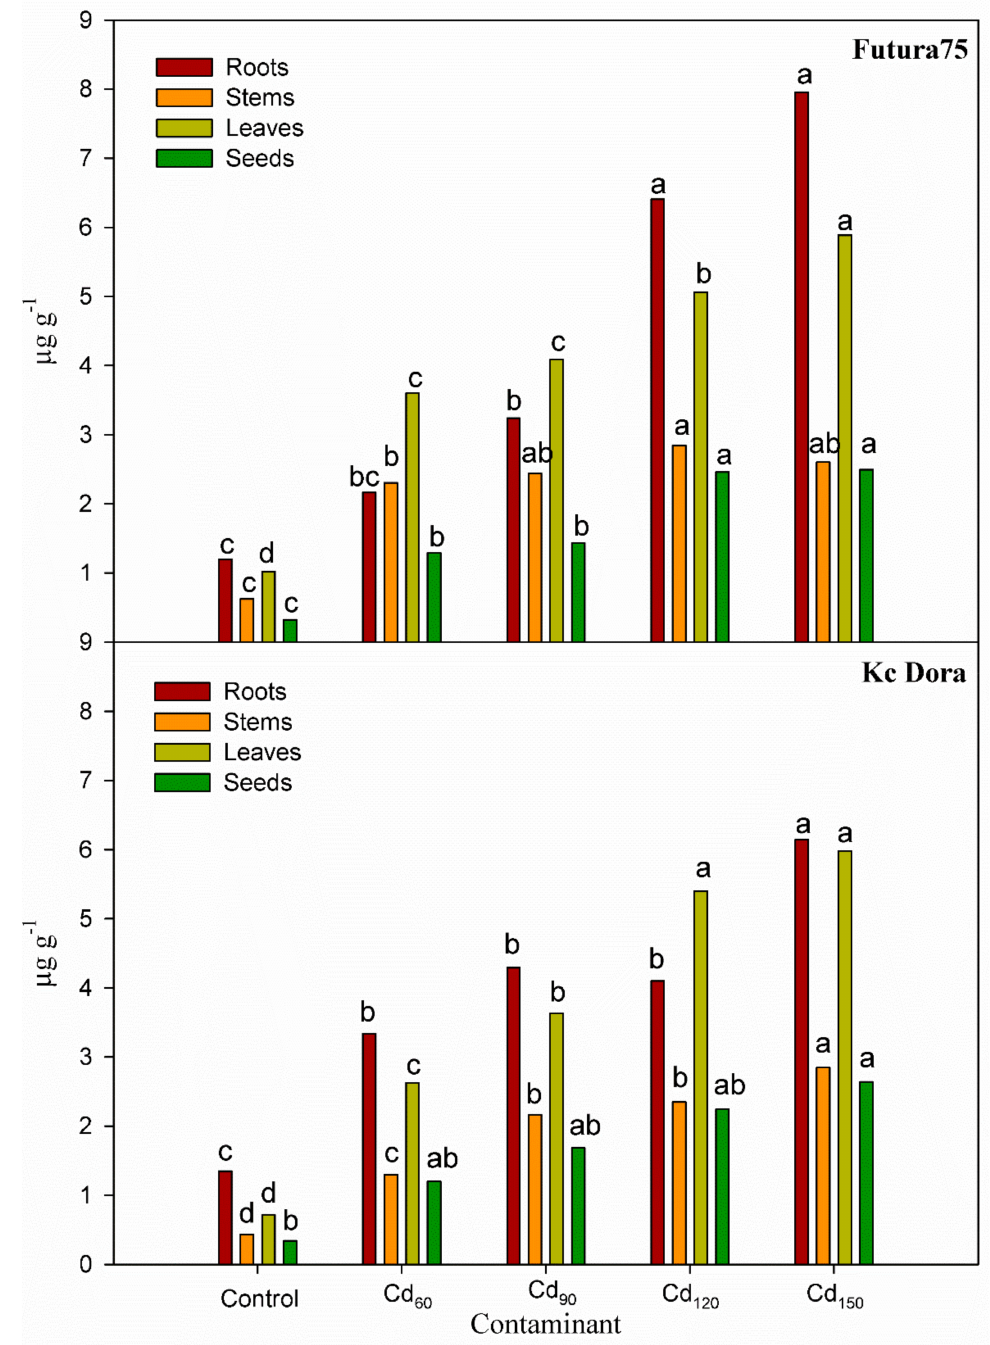
Figure 2. Concentration of cadmium ( µ g g − 1 ) in roots, stems, leaves, and seeds in Futura 75 and KC Dora. The comparisons were performed within the fractions of the plants. Different letters indicate significant differences between the means (according to HSD at p ≤